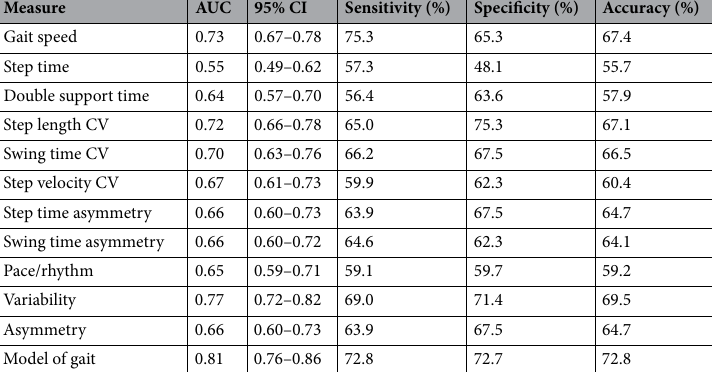
Table 3. Area under the curve (AUC) of the discriminating power of the eight gait variables, of the three factor scores and of the model. AUC values are reported for each measure, together with 95% confidence intervals (95% CI), sensitivity, specificity and